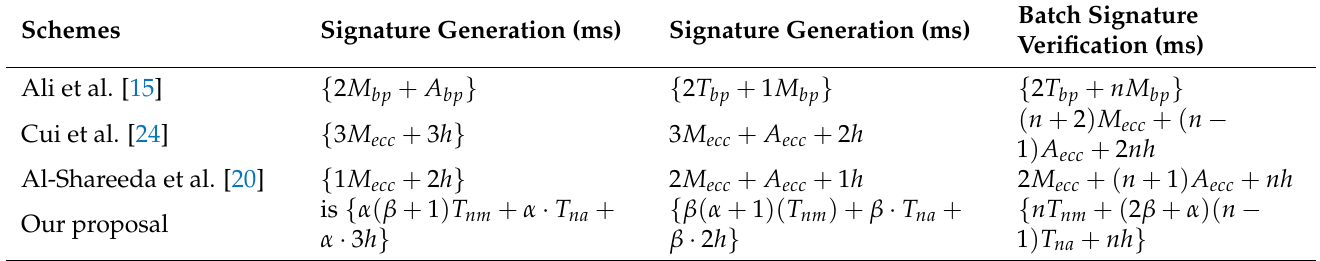
Table 2. Performance evaluation comparison.